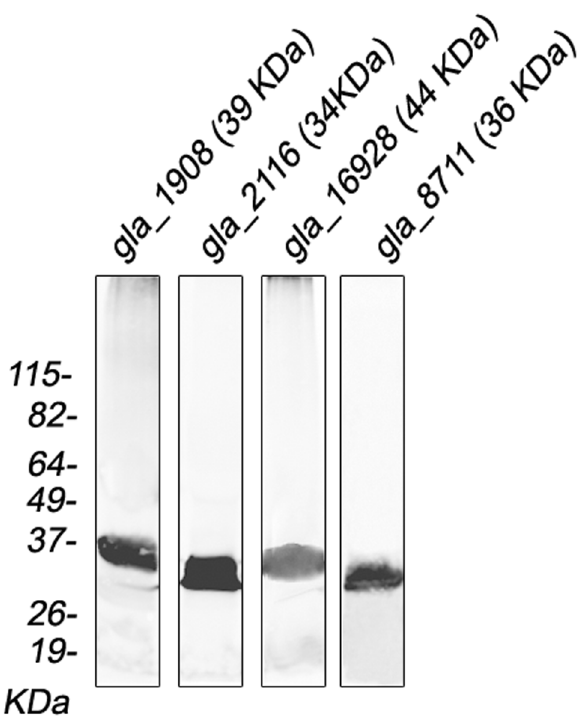
Figure 7. Expression of DHHC-HA proteins in Giardia tropho- zoites. Western blotting performed on total protein extracts from dhhc-ha transgenic trophozoites. Expected sizes are indicated in brackets. Relative molecular weights of protein standards (kDa) are indicated on the left.